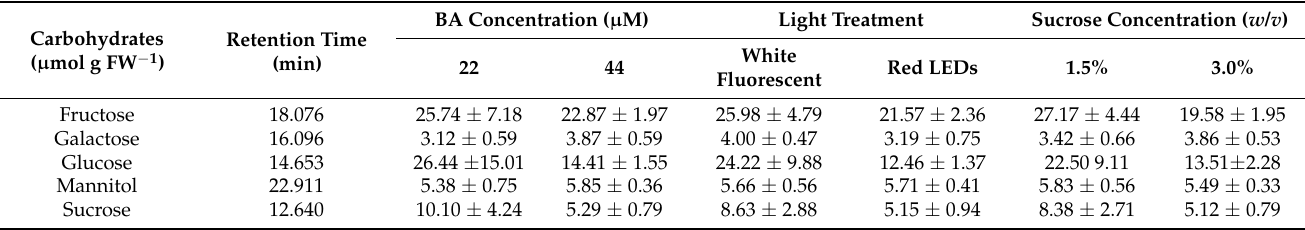
Table 2. Effect of 6-Benzyladenine (BA) (22 and 44 µ M) and sucrose concentration (1.5 and 3.0% ( w / v )) and light treatment (white fluorescent or red LEDs) on carbohydrate content of Pinus ra- diata D. Don shoots cultured in Quoirin and Lepoivre (LP) medium [27], modified according to Aitken-Christie et al. [28], supplemented with 2 gL − 1 activated charcoal after the rooting phase.